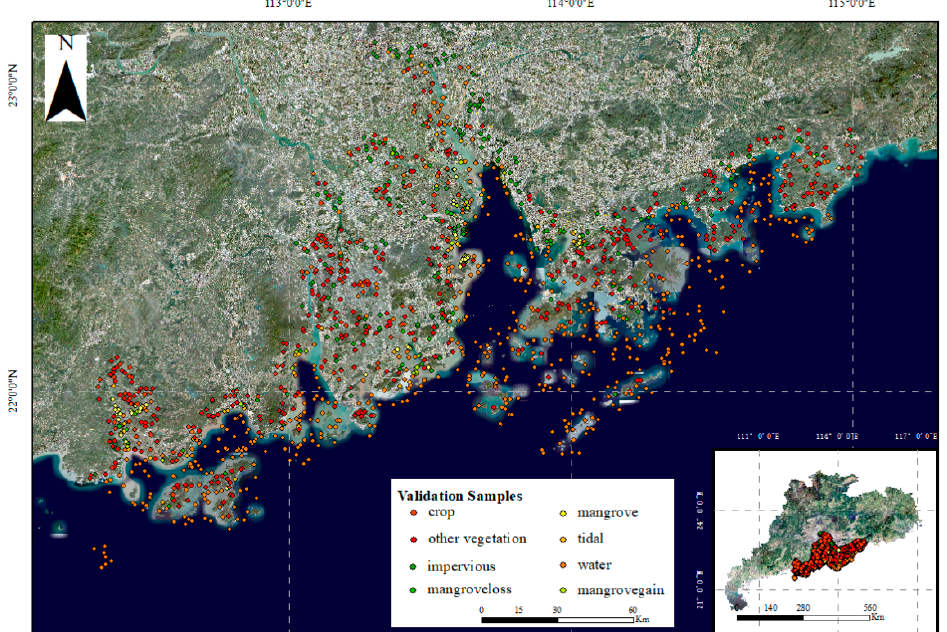
Figure 3. The locations of validation samples.